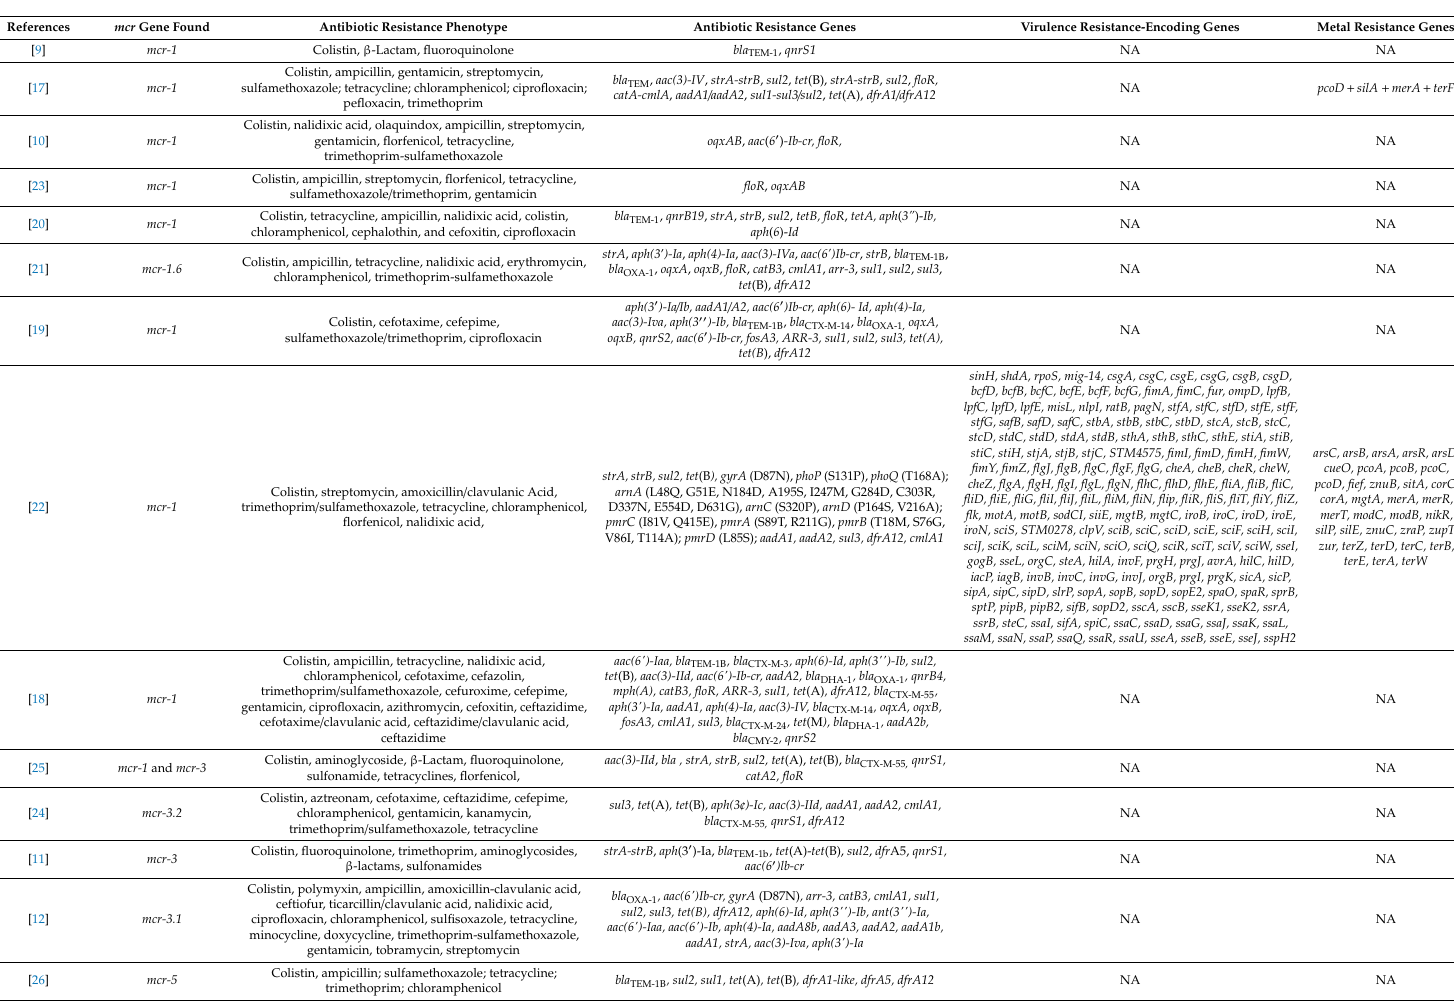
Table 3. Antibiotic resistance pattern, antibiotic resistance genes, virulence resistance-encoding genes and metal resistance genes found in mcr- positive ST34 isolates in di ff erent studies. NA = Not